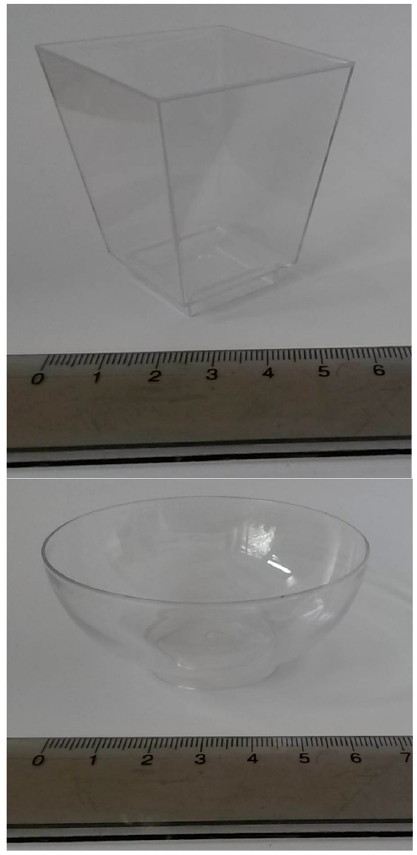
Figure 1. The angular ( above ) and round ( below ) cups used in the Study. Note: ruler measurement is metric (cm).